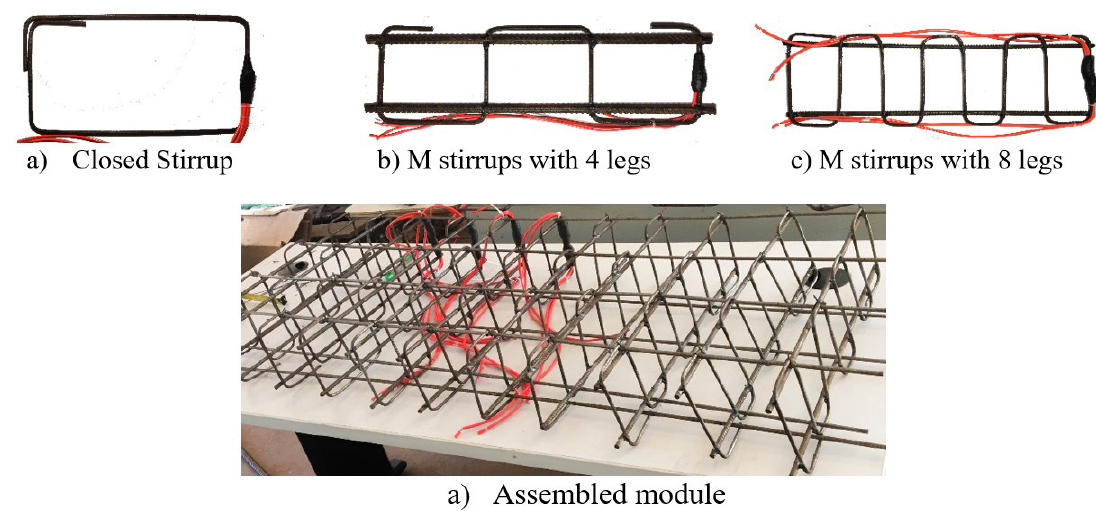
Figure 5 – Stirrups used in the